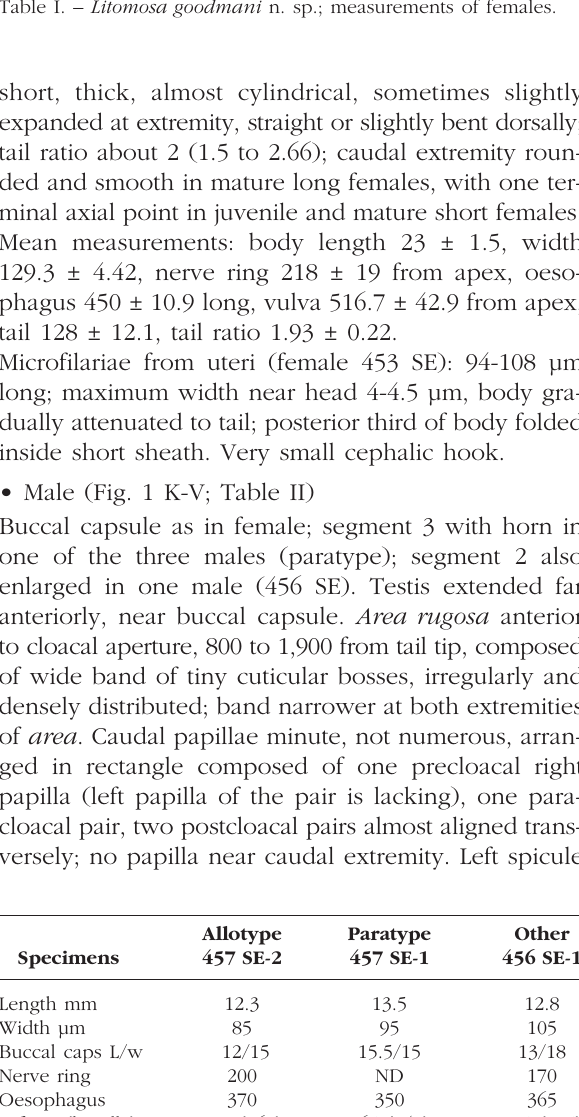
Table I. – Litomosa goodmani n. sp.; measurements of females.